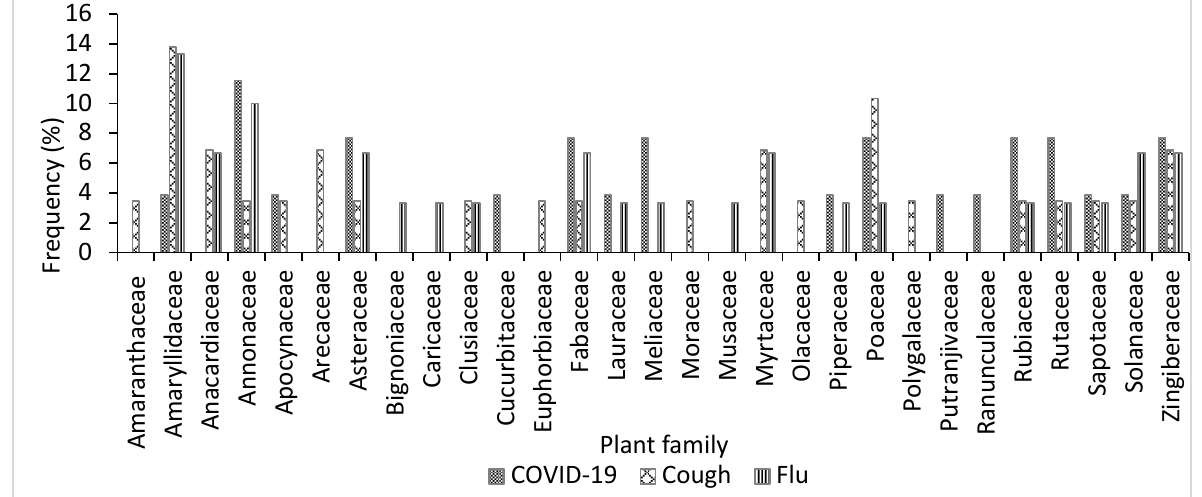
Figure 2. Frequency of plant families used for treating COVID-19, cough, and flu in Ogbomosho North and South Local Government Areas, Oyo State, Nigeria.